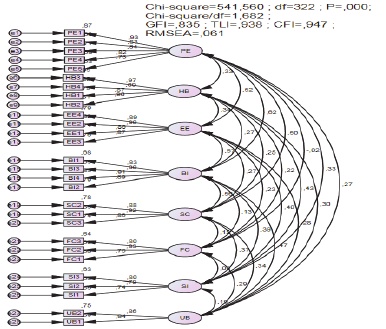
Fig. 2. Results of Confirmatory factor analysis